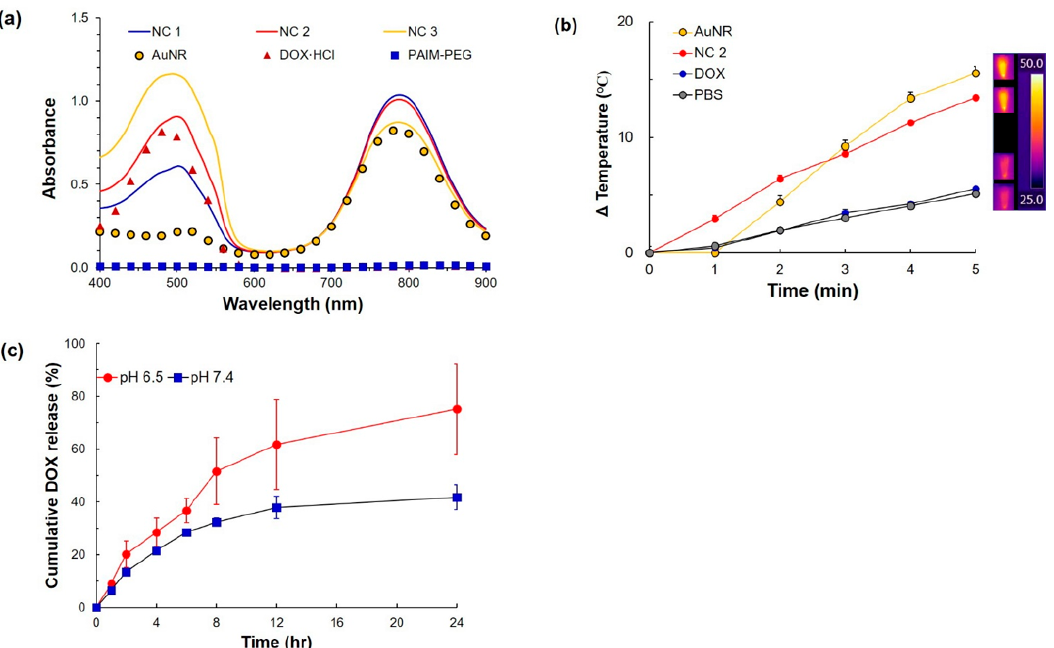
Figure 2. Photothermal effect: ( a ) absorption spectra, ( b ) heat generation by NIR laser (AuNR 1 μ g/mL, 808 nm, 2.0 W/cm 2 ), and ( c ) DOX release at different pH conditions (pH 7.4 and 6.5).